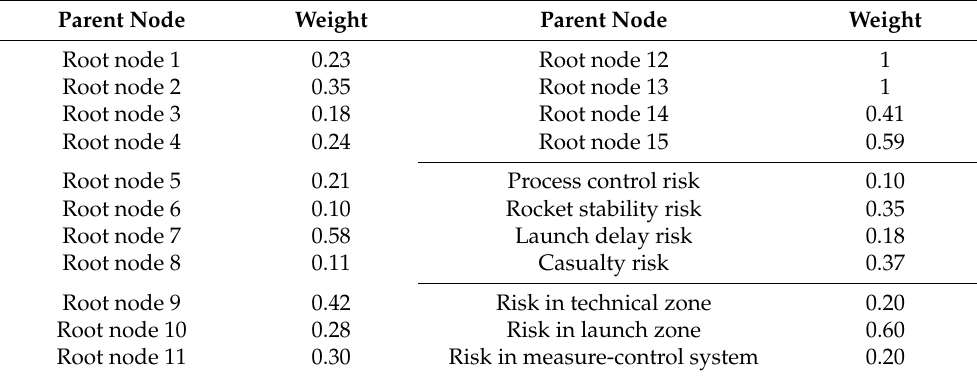
Table 7. Influencing weights of the parent nodes on the child